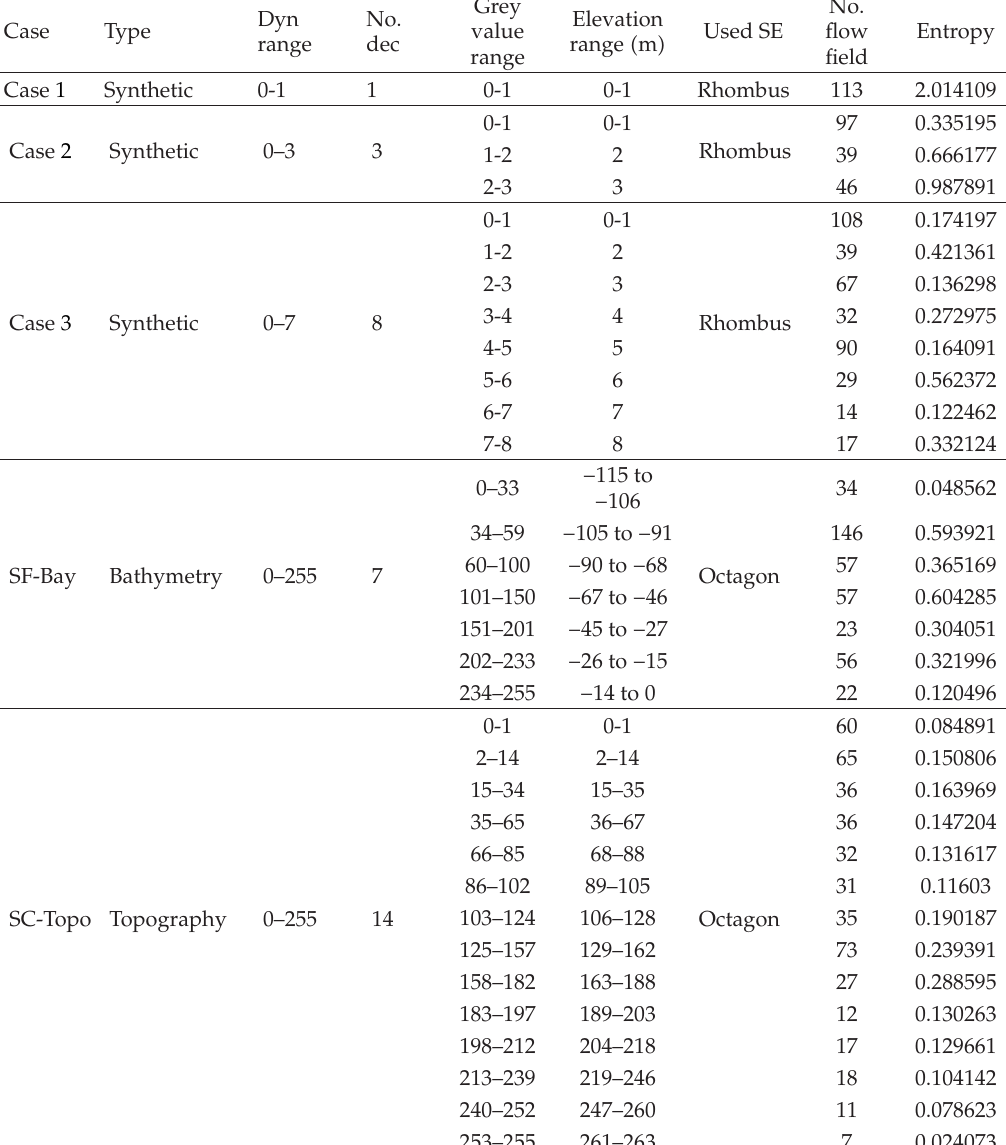
Table 1: Details of synthetic and realistic digital topographies considered with their grey levels’ and cor- responding elevation/or depth ranges, and entropy values estimated for each threshold elevation/depth decomposed set of each digital topographic